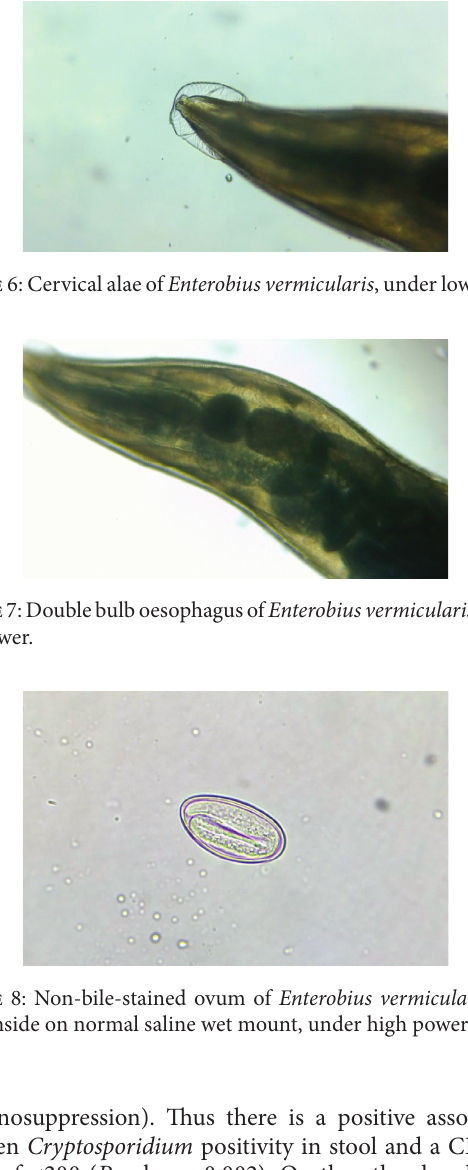
Figure 1: Mature Cystoisospora oocyst on normal saline wet mount, under high power.